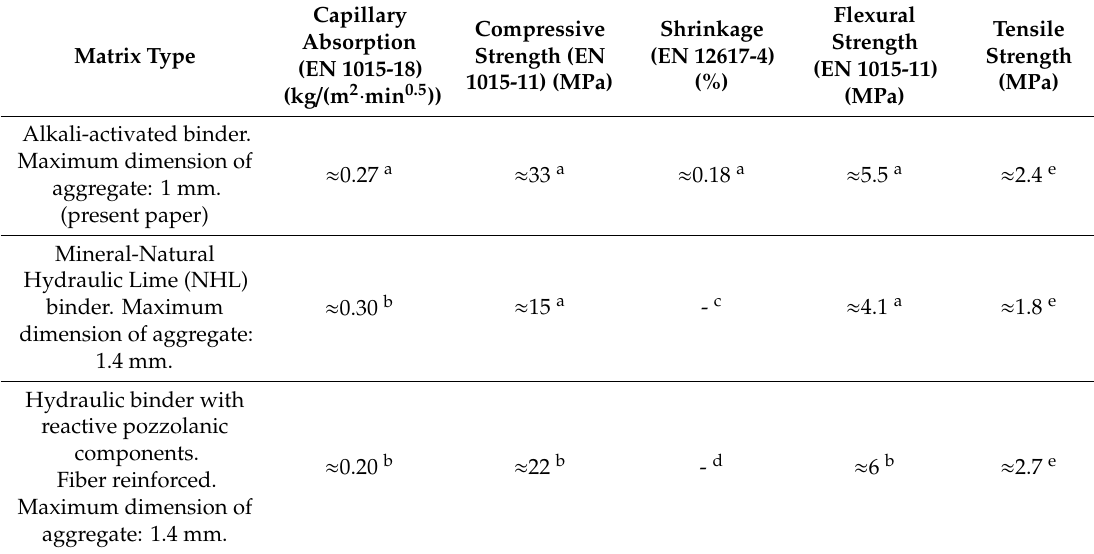
Table 3. Capillary absorption and mechanical properties of the alkali-activated mortar and of a selection of commercial mortars.